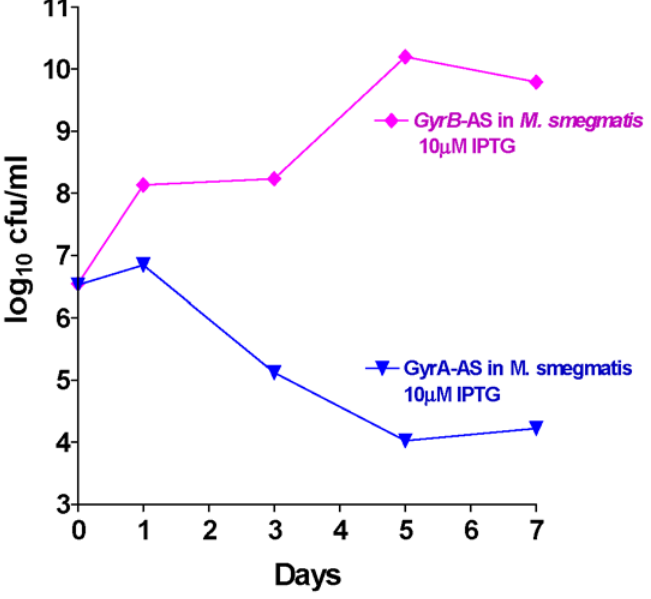
Figure 7. Survival kinetics of M.smegmatis (with M.tuberculosisgyr A-AS and gyrB –AS plasmids individually). Induction at 10 uM IPTG concentration. In the case of gyr A-AS r- M. smegmatis the cfu reduction is . 3 log10 (bactericidal target), but gyr B-AS showed no cfu reduction as the orphan gyrB takes over once the other gyrB transcript is blocked.